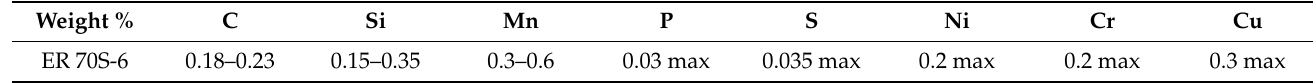
Figure 1. The WAAM process and the welding trajectories: ( a ) WAAM process, ( b ) strategy 1 ⎯ horizontal zigzag, ( c ) strategy 2 ⎯ lean zigzag, ( d ) strategy 3 ⎯ spiral, and ( e ) strategy 4 ⎯ curve zigzag. Table 2. Chemical composition of S20C steel base. Table 1. Mechanical properties of S20C (JIS) steel base.